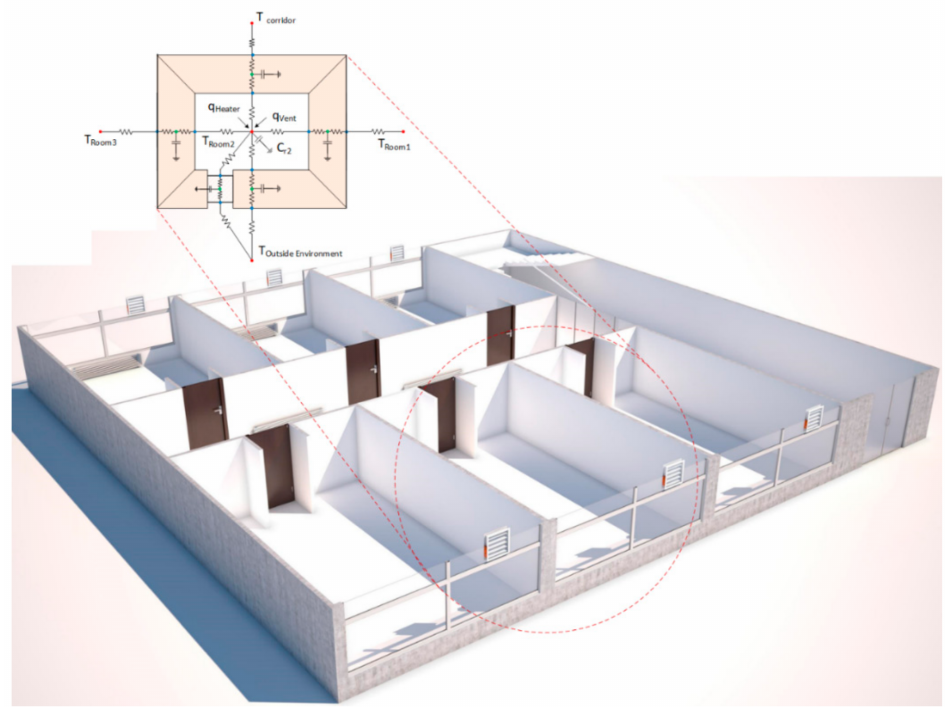
Figure 1. Schematic of the equivalent lumped capacitance model for a standard